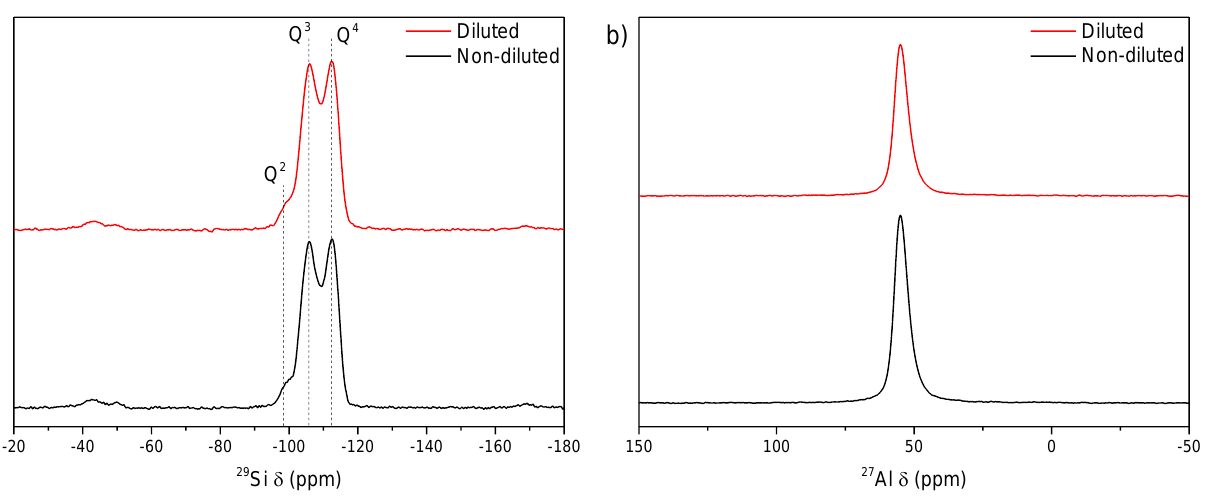
Figure 5. Solid-state NMR spectra of ( a ) 29 Si and ( b ) 27 Al in the samples synthesized for 24 h at 170 °C using nondiluted and diluted gels.